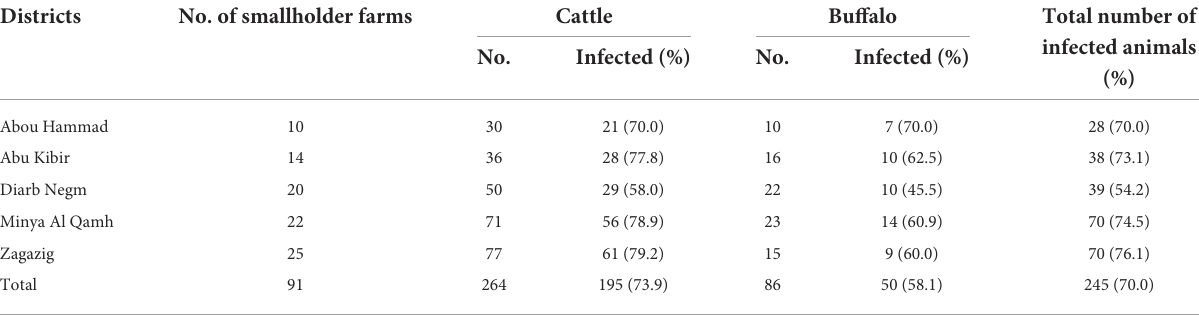
TABLE 1 Frequency distribution of smallholder farms and large ruminants selected for the study and tested for T. annulata- antibodies using IFAT from five districts of the Sharkia governorate, Egypt.